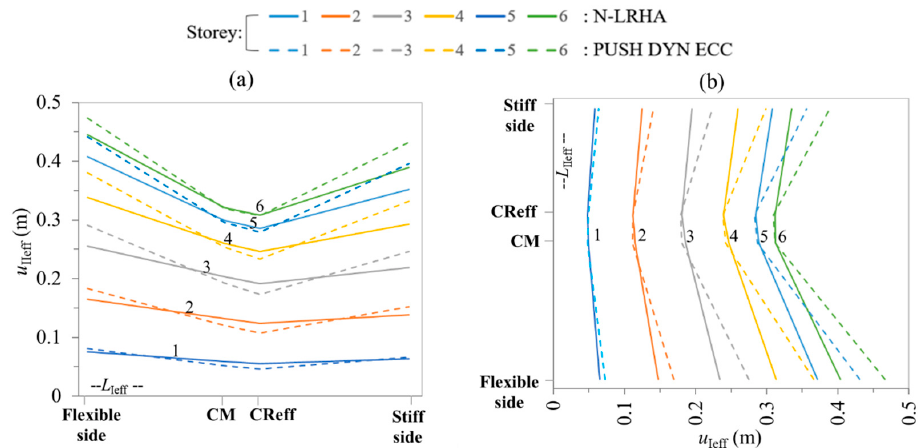
Figure 20. Plan inelastic displacement profiles of case 2 building at SD: ( a ) u IIeff along the II eff axis, ( b ) u Ieff along the I eff axis. Proposed pushover procedure vs. N-LRHA.